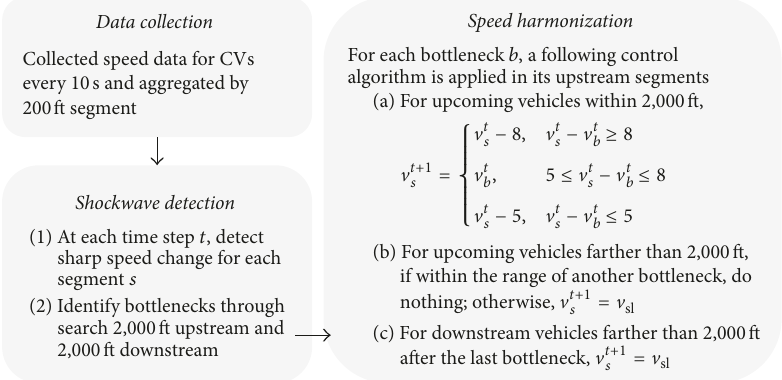
Figure 2: Shockwave detection and speed harmonization flow chart.